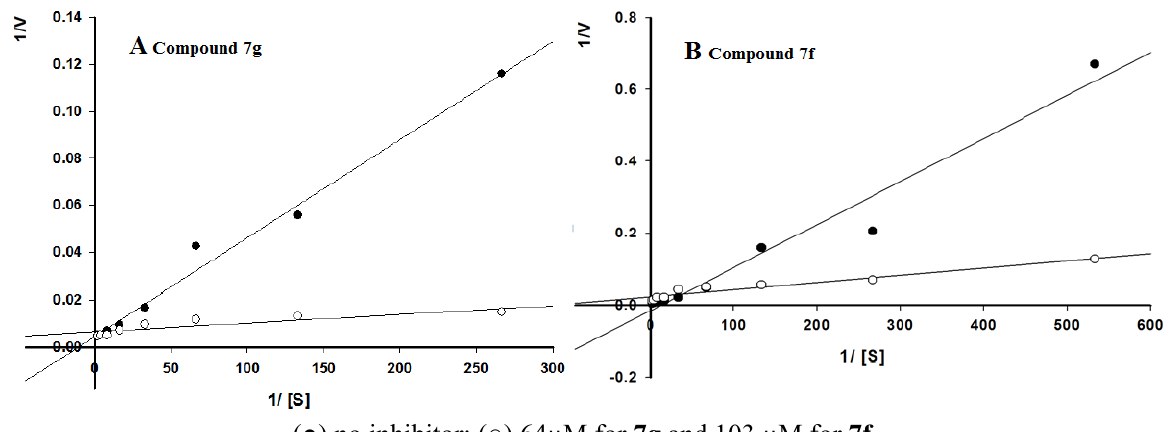
Figure 2. Lineweaver-Burk plot of AChE (0.02U) with substrate acetylthiocholine, in the absence and presence of inhibitors 7g ( A ), 7f ( B